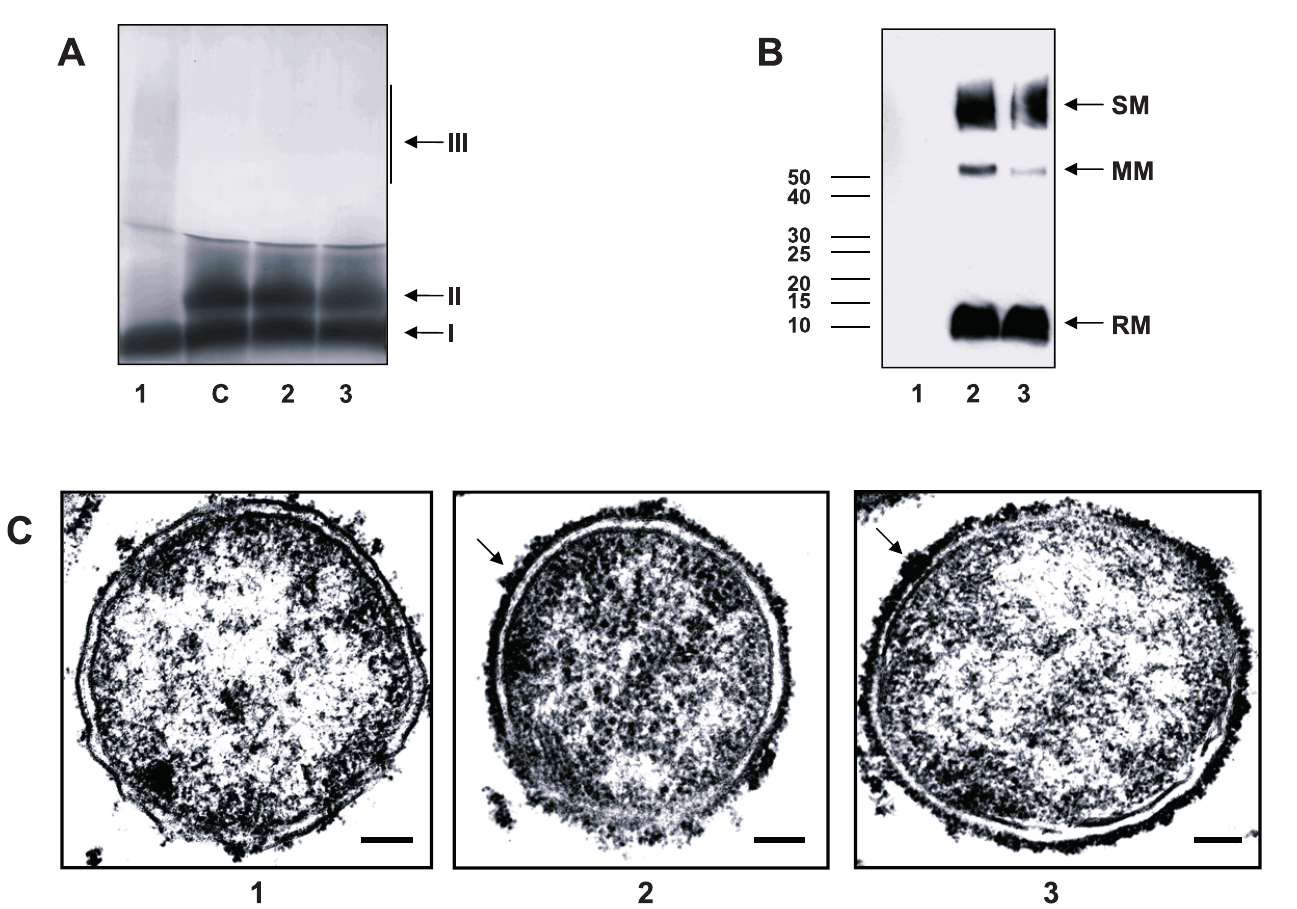
Figure 3. O1-to-O139 Transformants Produce O139 LPS and Antigenic Determinant and Are Encapsulated The acceptor strain A1552 (lane 1), the donor strain VCO139-Kan (lane 2), and a representative transformant (lane 3) were analyzed for LPS structure and for the presence of CPS and O-antigenic determinants. (A) LPS analysis. Purified LPS was subjected to SDS-PAGE (15% gel) and stained with silver. Specific signals, by arrows, depict the lipid A-core (I), the lipidA-core-O139 semi-rough LPS (II), and the lipidA-core-O1 LPS (III). The O139 parental strain MO10 [21] is shown in lane C. (B) O139-specific immunoblot analysis. Cell-lysates were separated in a 15% SDS gel, transferred onto a polyvinylidene fluoride membrane, and reacted with a -O139 polyclonal antibodies. Capsule-specific bands (SM, slowly migrating; MM, medium migrating) and O-antigen–specific bands (RM, rapidly migrating [14]) are indicated by arrows. (C) Detection of the CPS by electron microscopy. Cells were treated with polycationic ferritin and the CPS then visualized by transmission electron microscopy. The location of the capsule is indicated by arrows. Scale bar: 0.1 l m.